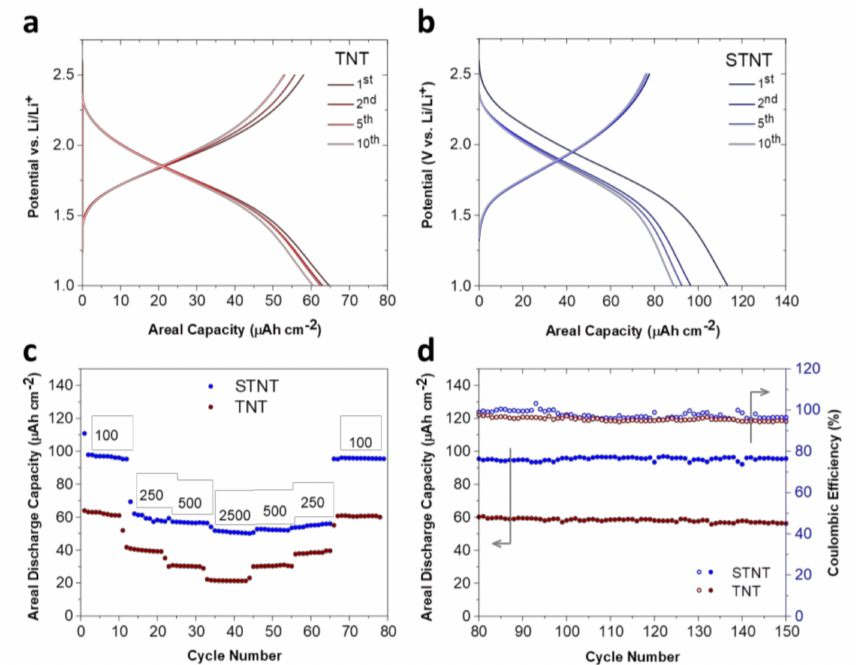
Figure 5. Galvanostatic voltage profiles at 100 µ A · cm − 2 for ( a ) TNT sample; ( b ) STNT sample, along with electrochemical performance; ( c ) rate capability for TNT and STNT samples showing areal discharge capacities; current rates are mentioned above the corresponding cycles in the unit of µ A · cm − 2 ; and ( d ) subsequent long-term cycling for TNT and STNT anodes; corresponding y -axes are marked with arrows.